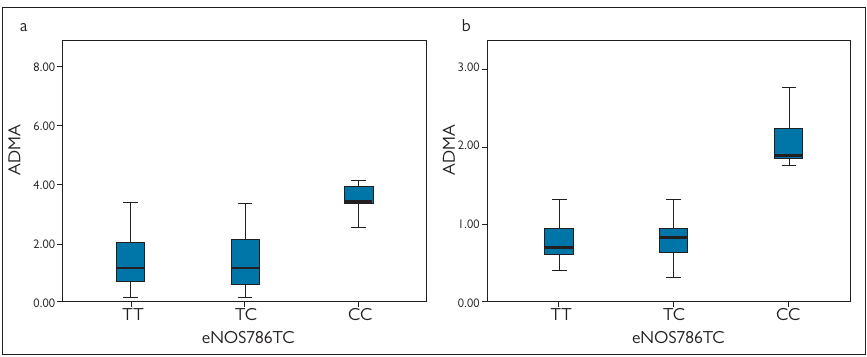
Figure 2. a, b. ADMA levels according to eNOS T-786C polymorphism in the patient (a) and healthy (b) groups